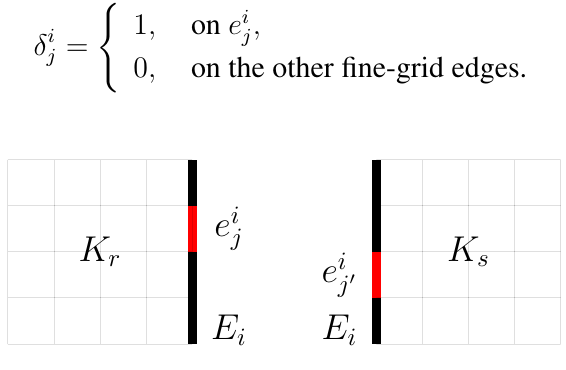
Figure 2. Neighboring coarse cells K